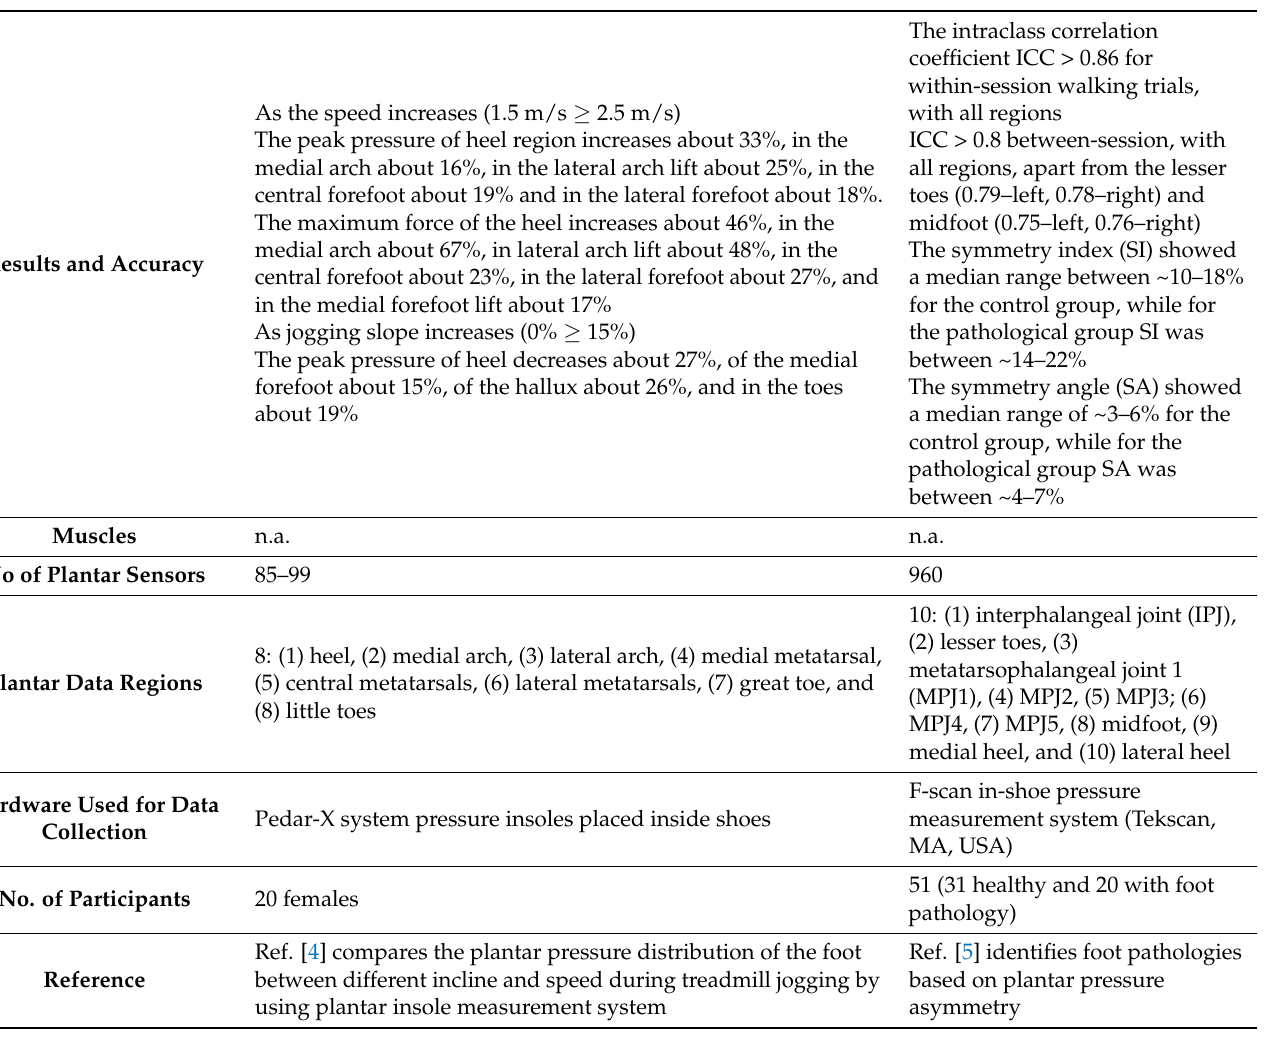
Table 3. Comparative presentation of the studied literature in a tabular